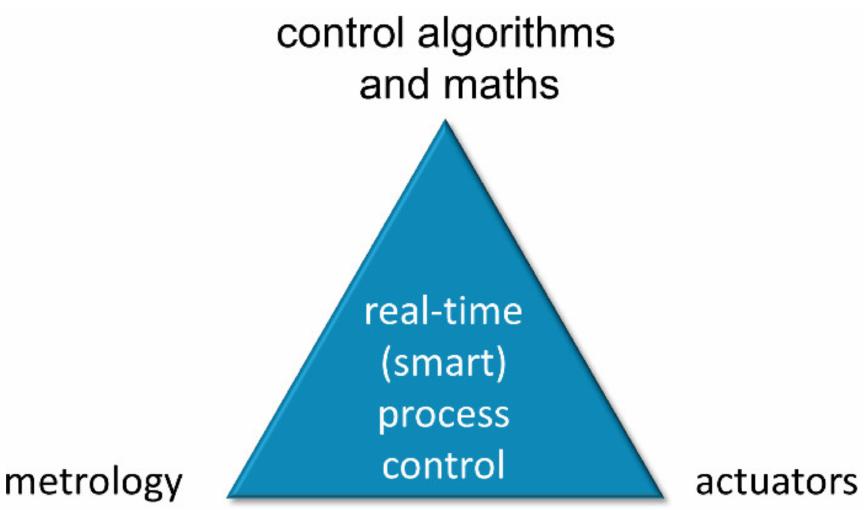
Figure 18. Trinity of real-time process control